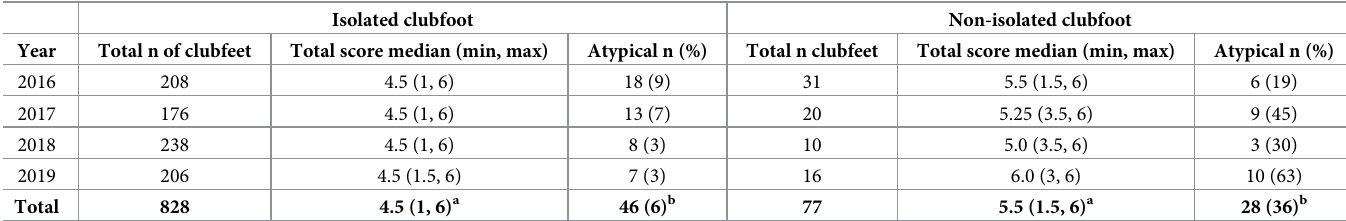
Table 3. Pirani score and presence of atypical signs at birth in clubfeet.